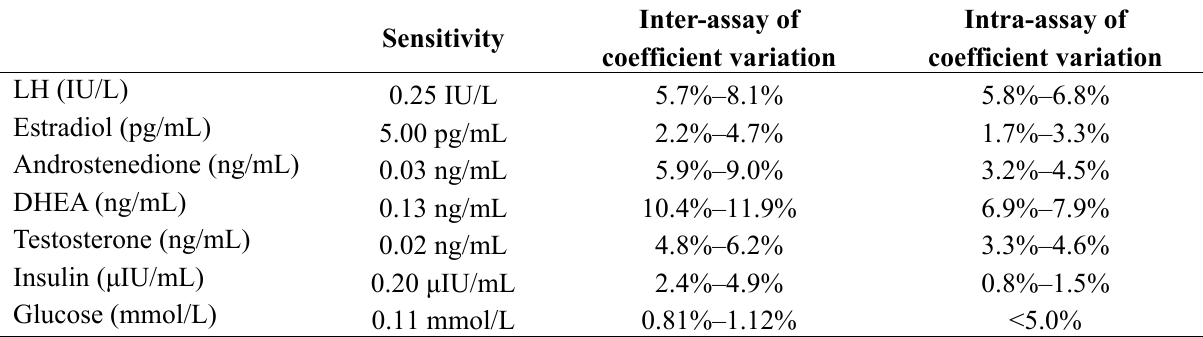
Table 1. Precision and sensitivity of